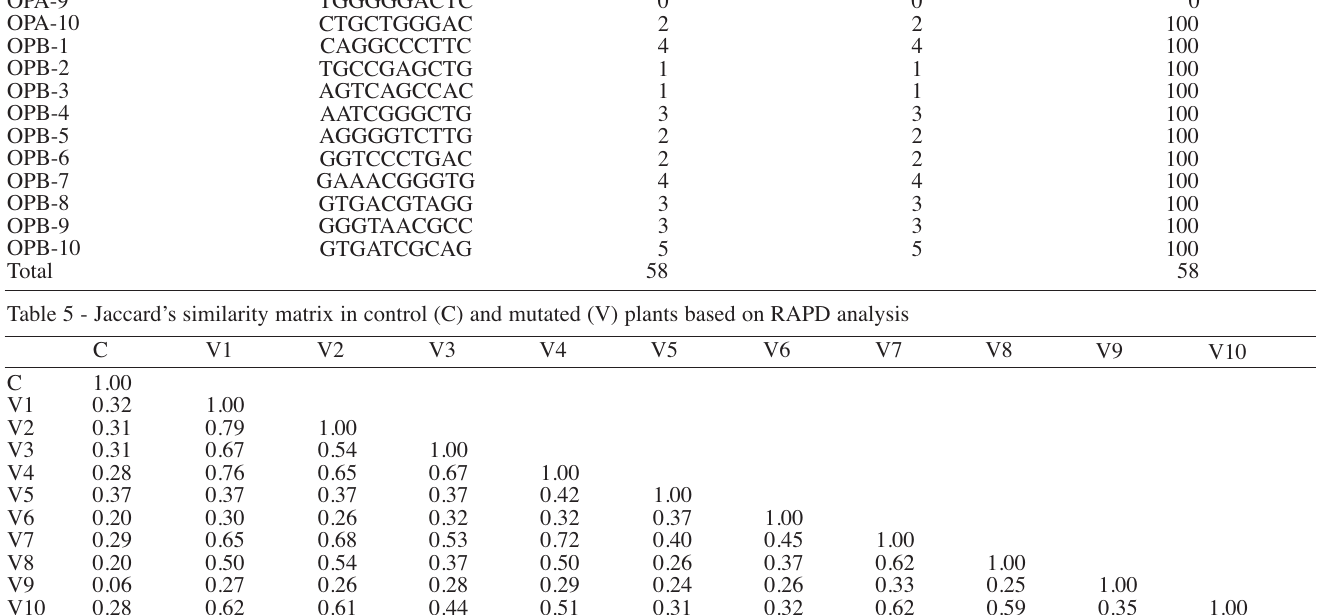
Polymorphic Polymorphism bands bands (%)